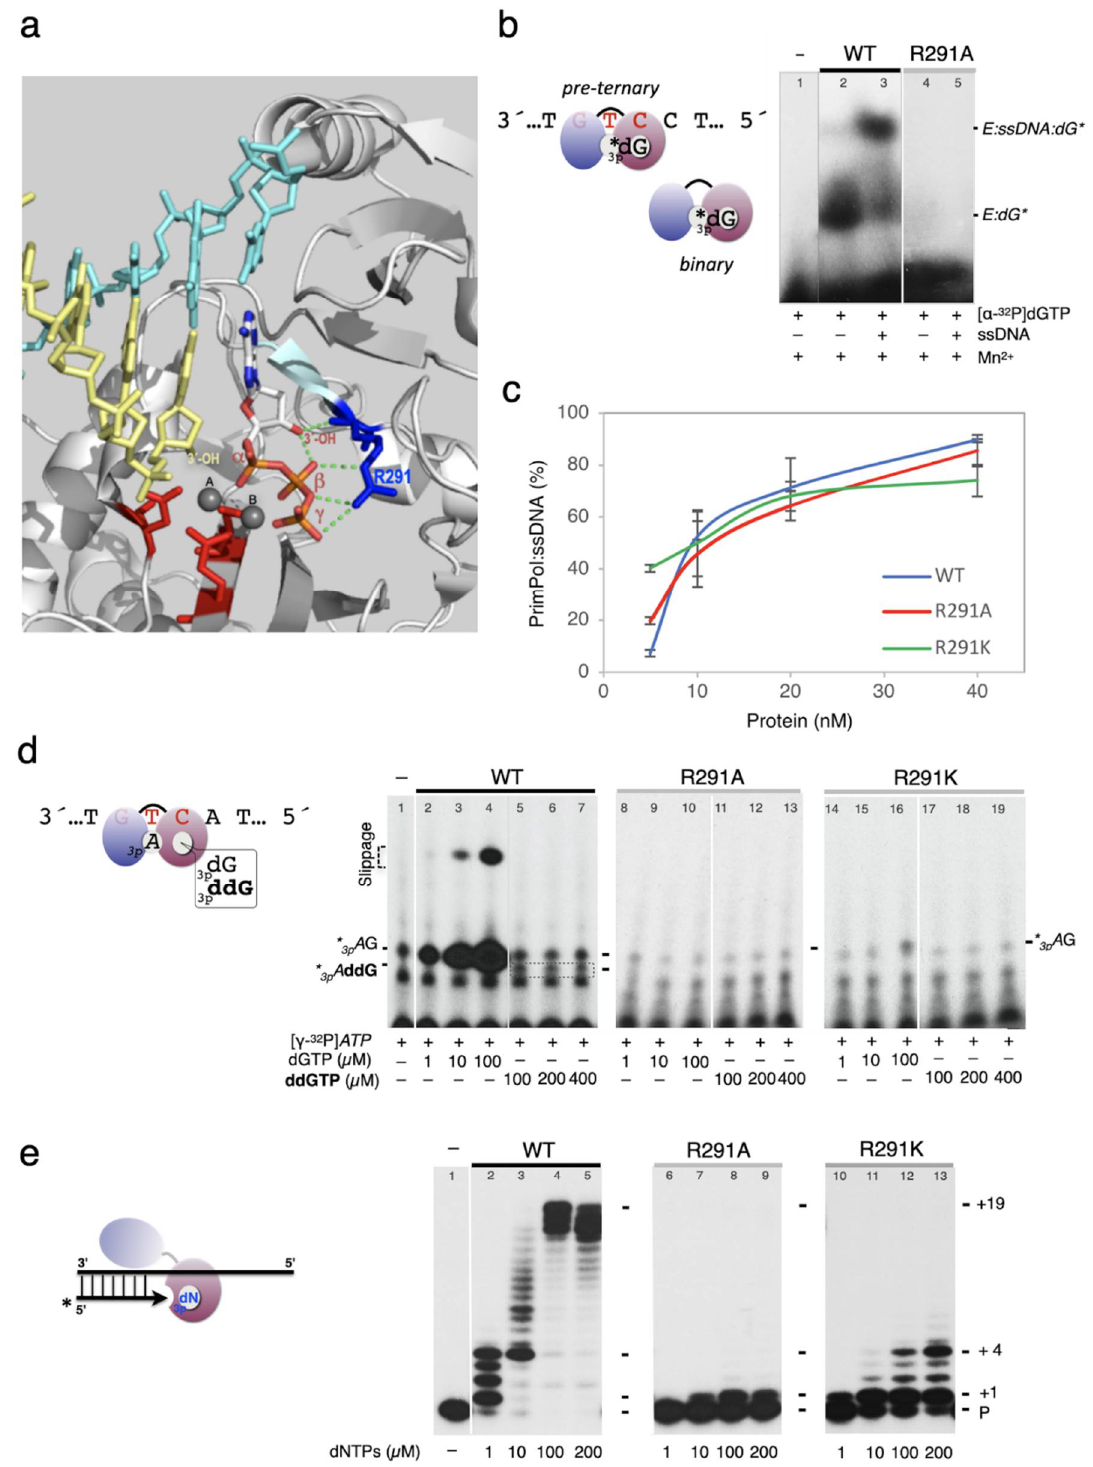
Figure 5. Critical role of Arg 291 , a ligand of the 3′-OH and the β-γ phosphate moieties of incoming 3′ dNTPs. ( a ) Ribbon representation of the ternary complex of Hs PrimPol:DNA:dATP, created with PyMol Molecular Graphics System (PDB id: 7JL8; [9]), depicting the interaction of PrimPol (grey) with DNA (primer strand is coloured in yellow and templating strand in cyan) and 3′ incoming dATP. Residues acting as metal ligands (Asp 114 , Glu 116 , Asp 280 ) are indicated in red, and the two metal ions A and B (Ca +2 ) as grey spheres. The invariant Arg 291 (R291; indicated in blue) interacts with the 3′-OH of dATP, forming a hydrogen bond with its backbone amino group, and also interacts with β and γ phosphates of the incoming nucleotide, likely contributing to the correct orientation and stability of the substrate, and catalysis of the phosphodiester bond. In addition, it could be responsible for the strong preference for dNTPs over ddNTPs. ( b ) PrimPol:dNTP (binary) and PrimPol:ssDNA:dNTP (ternary) complexes detected by EMSA, using [α- 32 P]dGTP (16 nM), 1 mM MnCl 2 (as